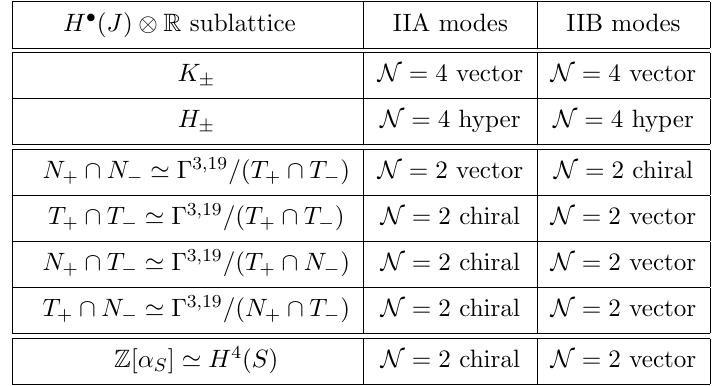
Table 1 . Structure of the massless spectra for type II compacti(cid:12)cations on TCS. Here we show the spectrum in the C (3) duality frame for IIA. For IIB we chose to use the vectors arising from C (4)+ and we work with C (2)